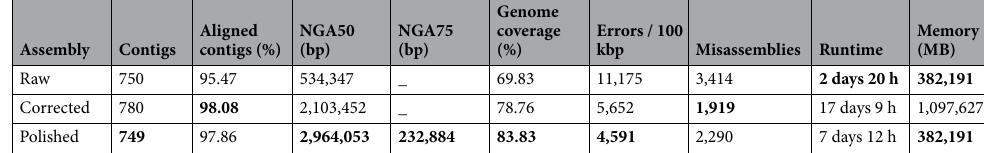
Table 6. Statistics of the different assemblies for the full H. sapiens dataset. Raw corresponds to the assembly generated from raw reads. Corrected corresponds to the assembly generated from corrected reads. Polished corresponds to the assembly generated from raw reads, and polished with CONSENT. Runtime and memory consumption are reported for the whole correction + assembly or assembly + polishing pipelines. QUAST-LG did not provide a metric for the NGA75 of the assembly generated from corrected reads. Best results for each metric is highlighted in